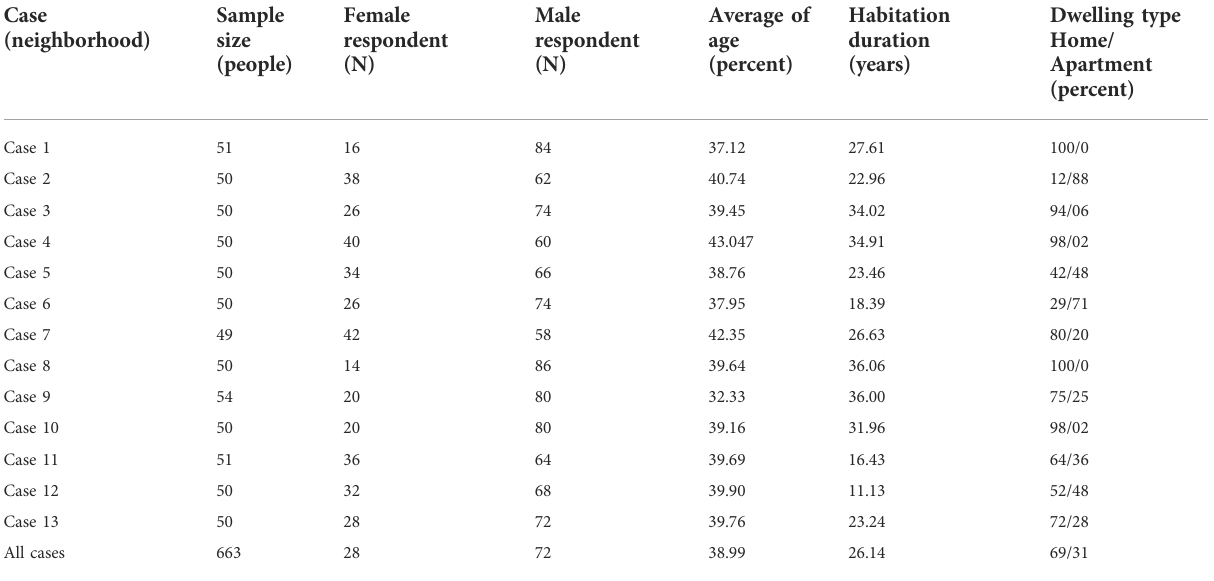
TABLE 4 Sample size and features of